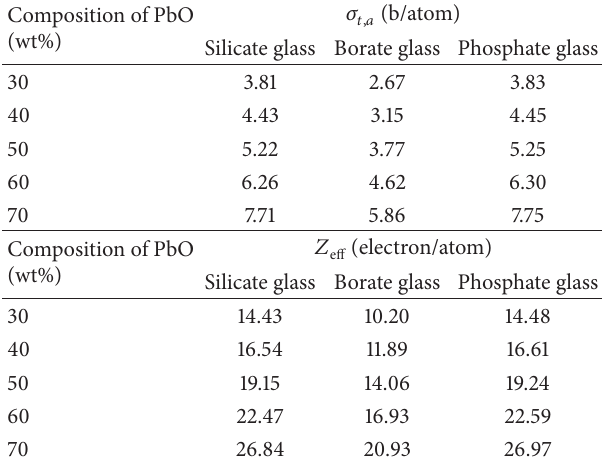
Table 3: Total atomic cross-sections and effective atomic numbers of PbO containing silicate, borate, and phosphate glass system at 662 keV.